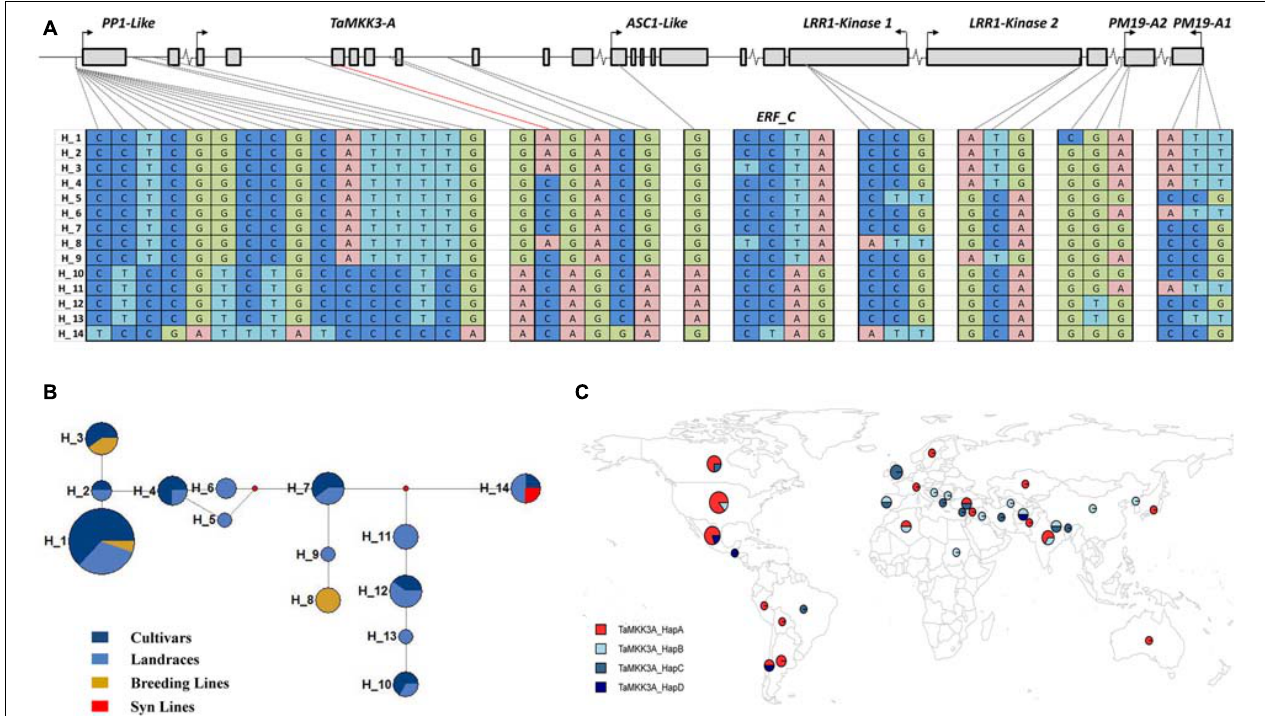
FIGURE 3 | Phs-A1 haplotype analysis. (A) Structure of 14 haplotypes identified in the HapMap population across 39 SNP loci in the Phs-A1 interval. SNP loci are ordered based on their physical position on the Zavitan assembly. Exons, intron and intergenic regions are represented by filled boxes, solid lines and breaks, respectively. Note that ERF-C is not on the Zavitan assembly. (B) Haplotype network of the 14 haplotypes. The size of each circle corresponds to the number of lines in each haplotype. Blue, light blue, amber and red represent cultivars, landraces, breeding and synthetic line in each haplotype, respectively. (C) Geographical distribution of the four TaMKK3-A haplotypes (Supplementary Table S3). The size of the circle represents the sample size obtained within each country while each section represents the proportion of the country sample size with the specified haplotype.